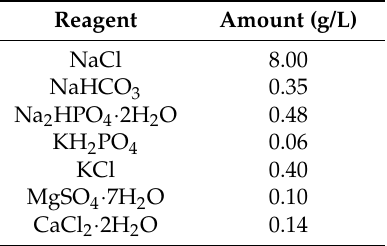
Table 2. Compositions of the Hank’s balanced salt